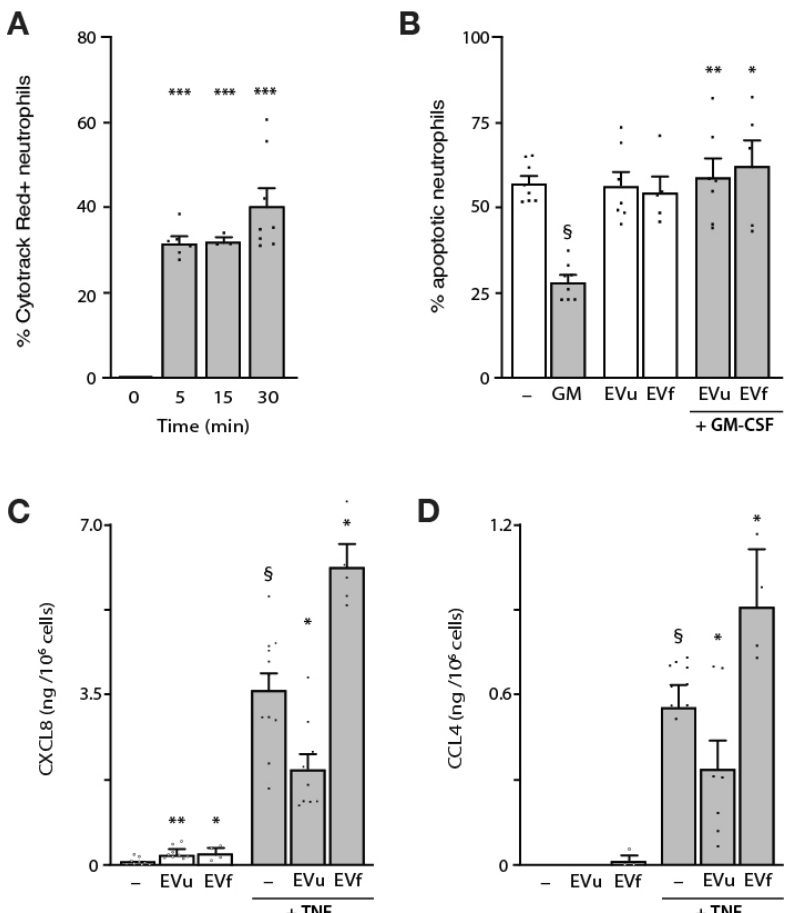
Figure 5. Incorporation of NDEs into autologous neutrophils and its consequence on their apoptotic rate and chemokine production. ( A ) NDEs from unstimulated neutrophils disrupted by nitrogen cavitation were stained with Cytotrack Red, washed, and co-cultured with autologous neutrophils at a ratio of 5 NDEs per recipient cell (NDEs were quantified as described in Figure 1 for triple-positive EVs). Reactions were stopped at the indicated times, and the cells were collected and analyzed by flow cytometry for Cytotrack Red fluorescence. Mean ± s.e.m. from at least 3 independent experiments. ***, p < 0.001; vs. unstimulated cells. ( B ) Neutrophils were cultured for 18 h in the absence of any stimulus (“–”) or in the presence of 1 nM GM-CSF, NDEs from the cavitates of un- stimulated neutrophils (“EVu”, at a 5:1 NDE:cell ratio), NDEs from the cavitates of fMLP-stimulated neutrophils (“EVu”, at a 5:1 NDE:cell ratio), or a combination thereof. Cells were then processed for flow cytometry analysis of apoptotic cells (AnnexinV + , PI − ). Mean ± s.e.m. from at least 5 independ- ent experiments. *, p < 0.05; **, p < 0.01; vs. GM-CSF alone. §, p < 0.001 vs. unstimulated cells. ( C ) Neutrophils were cultured for 6 h in the absence of any stimulus (“–”) or in the presence of 100 U/mL TNFα, NDEs from the cavitates of unstimulated neutrophils (“EVu”, at a 5:1 NDE:cell ratio), NDEs from the cavitates of fMLP-stimulated neutrophils (“EVf”, at a 5:1 NDE:cell ratio), or a com- bination thereof. Culture supernatants were analyzed by ELISA for their CXCL8 content. Mean ± s.e.m. from at least 4 independent experiments, each performed in duplicate. §, p < 0.001 vs. unstim- ulated cells; *, p < 0.05; **, p < 0.01; vs. matched condition without NDEs. §, p < 0.001 vs. unstimulated cells. ( D ) The same samples described in panel C were analyzed by ELISA for their CCL4 content.